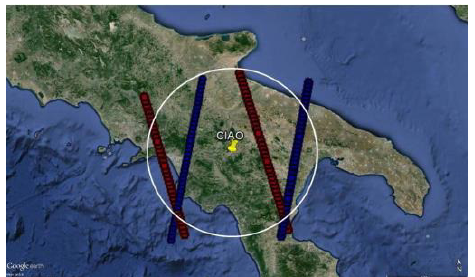
Figure 1. Nighttime (blue) and daytime (red) CALIPSO overpass traces within 100 km from CIAO observatory (white circle). Aerial photography courtesy of Google Earth (http://earth.google.com/).